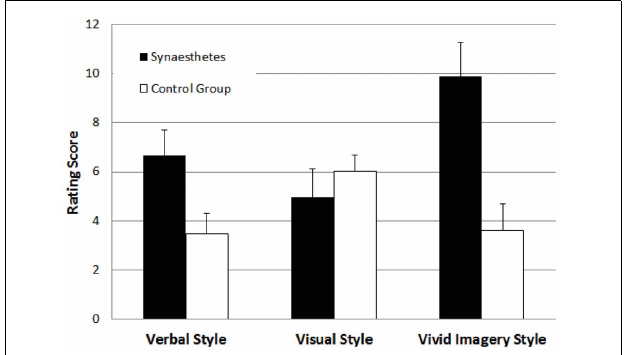
FIGURE 4 | Mean ratings for participants with and without grapheme-color synaesthesia on the verbal style, the visual style, and the vivid imagery cognitive style dimensions in Study 2. Error bars represent standard